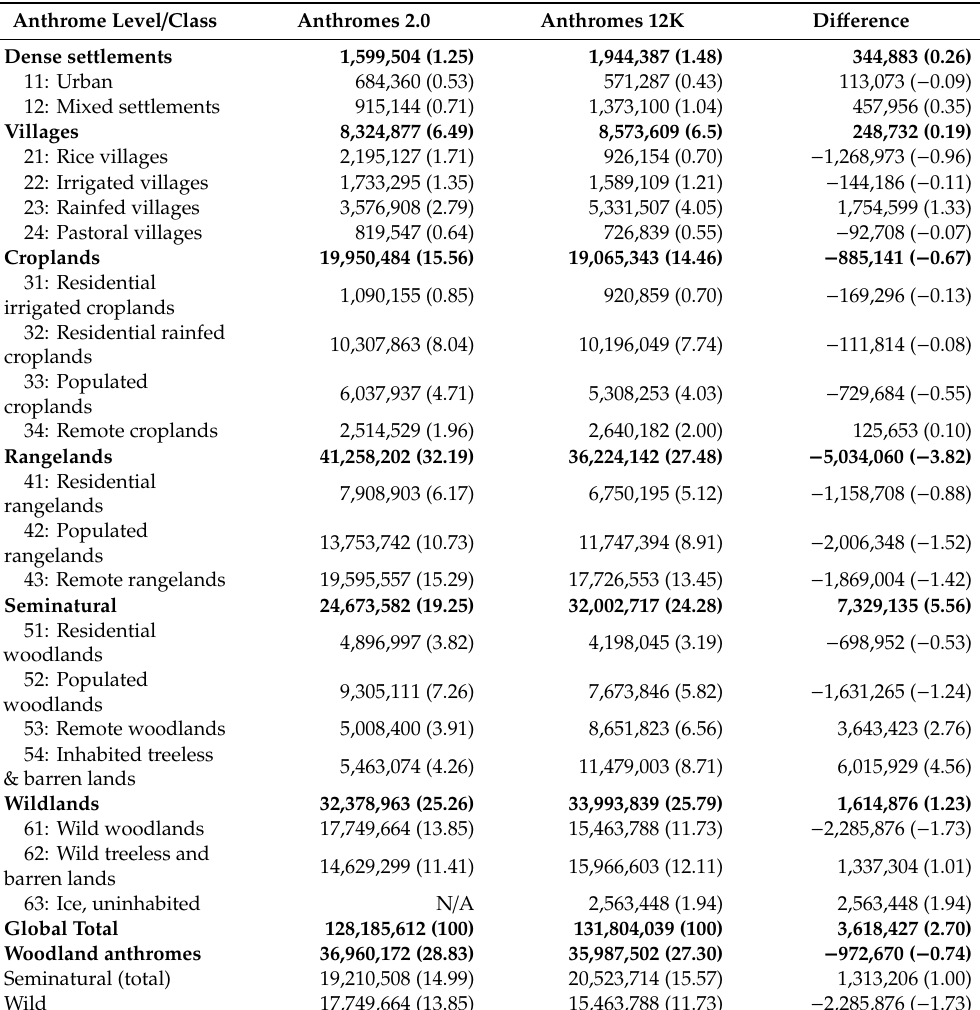
Table 3. Comparison of 2000 CE anthrome levels ( bold text ) and classes in Anthromes 12K and Anthromes 2.0. Global land areas in km 2 , with percent global land area in parentheses. Di ff erence computed by subtracting Anthromes 2.0 from Anthromes